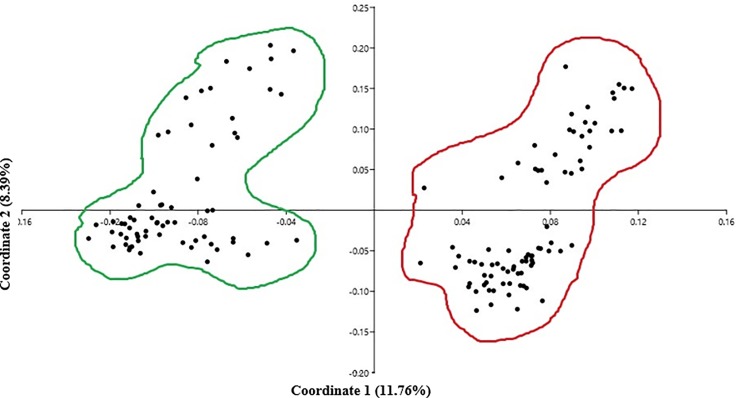
PCoA analysis of 148 barley cultivars and division of the population into two distinct sub-groups.